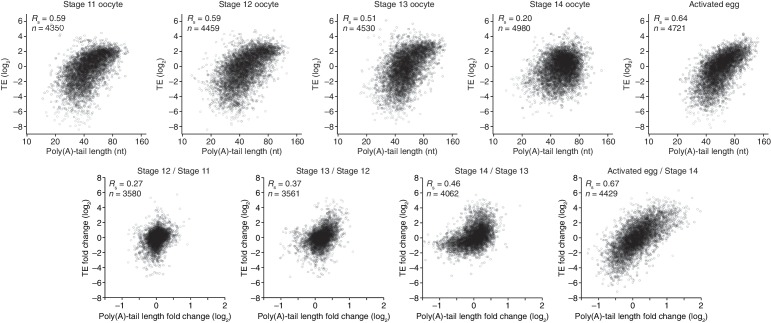
Coupling between poly(A)-tail length and translational efficiency in oocytes.Relationship between mean poly(A)-tail length and TE in either oocytes at the indicated stage or activated eggs (top), and the relationship between tail-length and TE changes observed between adjacent stages (bottom). TE values (log2) were median centered (median values in stage 11, 12, 13, and 14 oocytes and activated eggs were –0.6641, –0.9006, –1.38, –0.2523, and –0.0158, respectively). TE fold-change values (log2) were median centered for each comparison (median values, –0.1961, –0.3969, 1.0886, and 0.2123 from left to right). The TE data for stage 14 oocytes and activated eggs were from Kronja et al. (2014b), and the plot of mean poly(A)-tail length and TE for the stage 14 oocyte is redrawn from Figure 1B. Otherwise, these panels are as in Figure 1B.